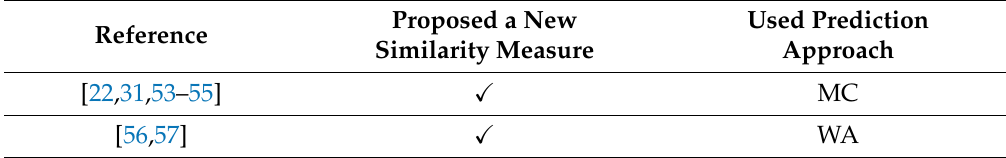
Table 5. A list of notable references on the improvement of CF-based RS via a new